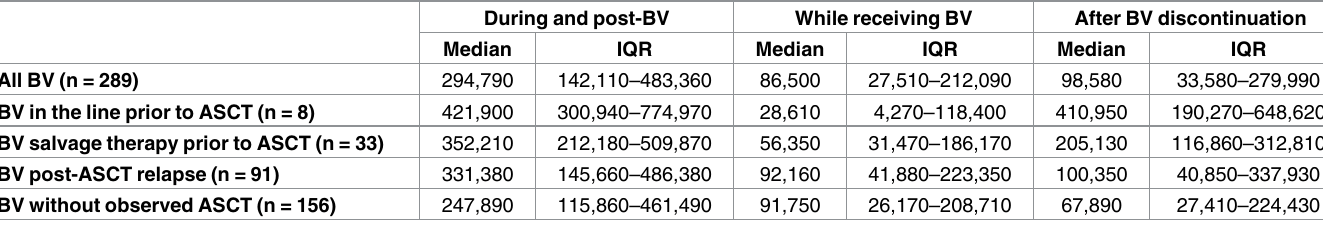
Table 4. Median (IQR) total (between all-cause costs (USD), according to timing with respectto BV treatment.